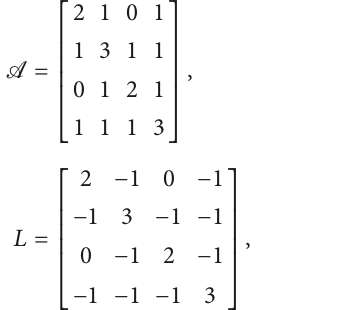
the corresponding Laplacian matrix of G are, respective-